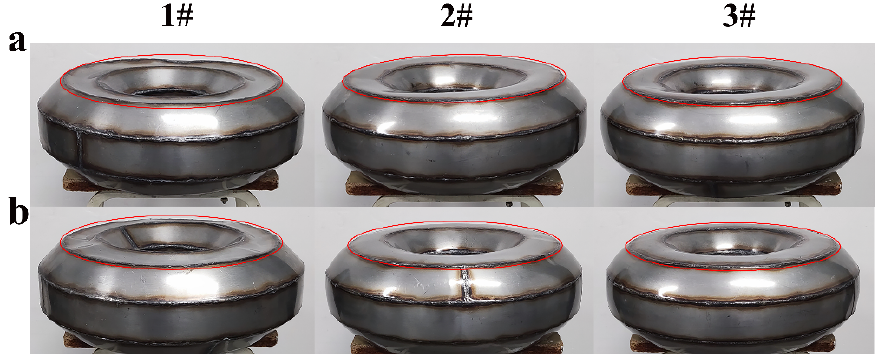
Figure 18. Photographs of two hydroformed toroids and one preformed toroid after hydrostatic tests: ( a ) main view and ( b ) rear view.